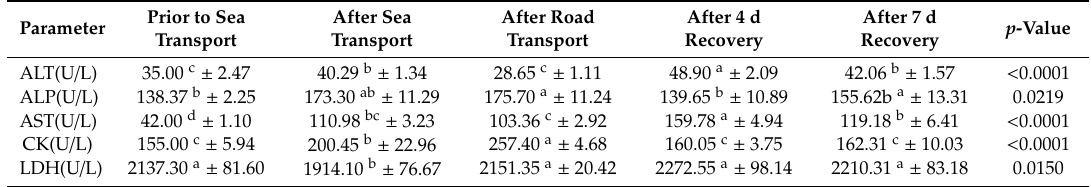
Table 1. E ff ects of sea and road transport on blood biochemical parameters in cattle (Mean ± SE). Prior to Sea After Sea Parameter Transport Transport